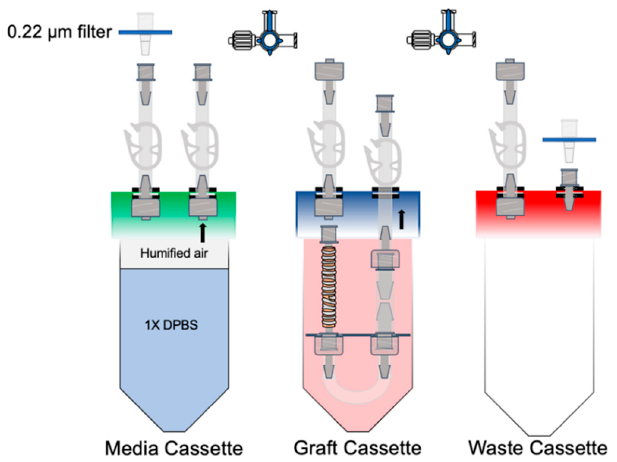
Figure 4. Air–liquid interface set ‐ up. The same cassettes from the recellularization process were used. The media cassette was partly filled with 1X DPBS, and the syringe pump introduced air through the 0.22 ‐μ m filter to create humidified air. This was pushed through the circuit at 0.5 mL/h. The circuit was flushed with 5 mL of 1X DBPS daily.